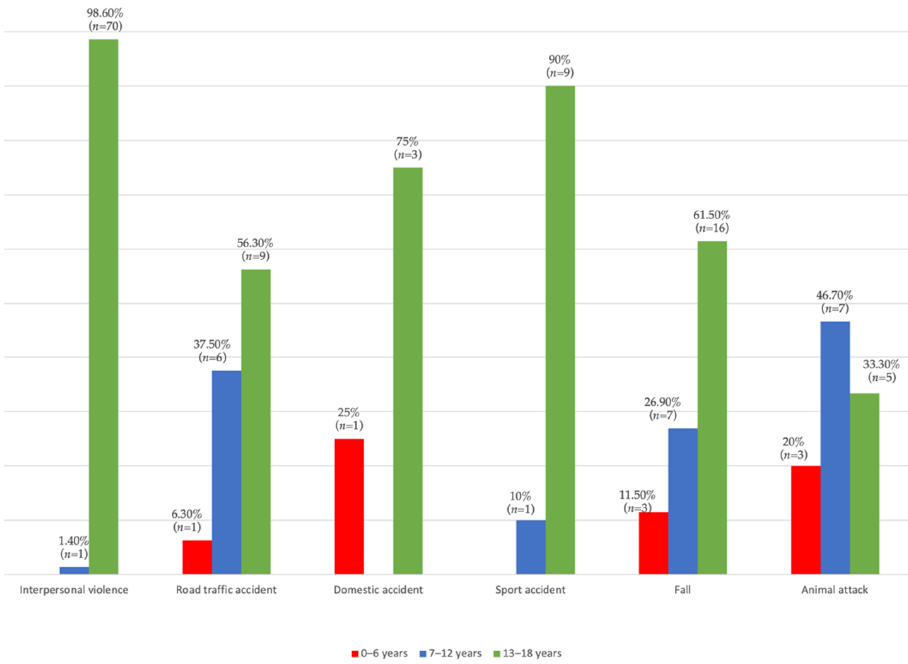
Figure 2. Distribution according to age and etiology.